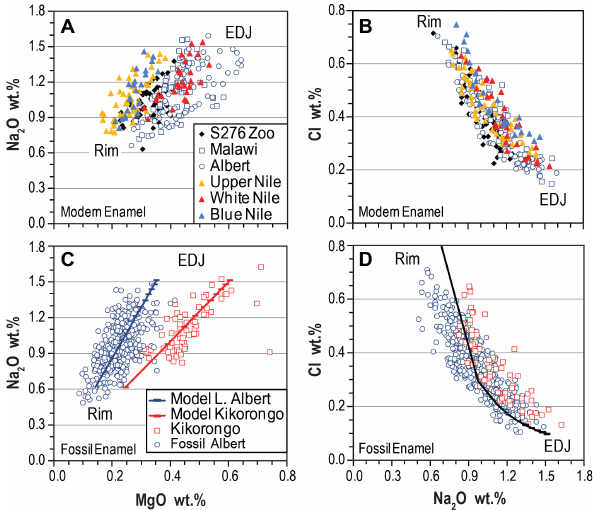
Fig. 8. Variation of MgO, Na 2 O, and Cl in modern and fossil enamel from Hippopotamid molar teeth. Note the coherent varia- tion of Cl and Na 2 O in fossil and modern enamel but distinct MgO contents in enamel from different environments. Blue and red lines represent model calculation assuming fractional crystallization of apatite. For more details see text and Table 6. (a) and (c) : MgO versus Na 2 O variation in enamel of modern and fossil molar teeth (b) and (d) : Na 2 O versus Cl variation in enamel of modern and fossil molar